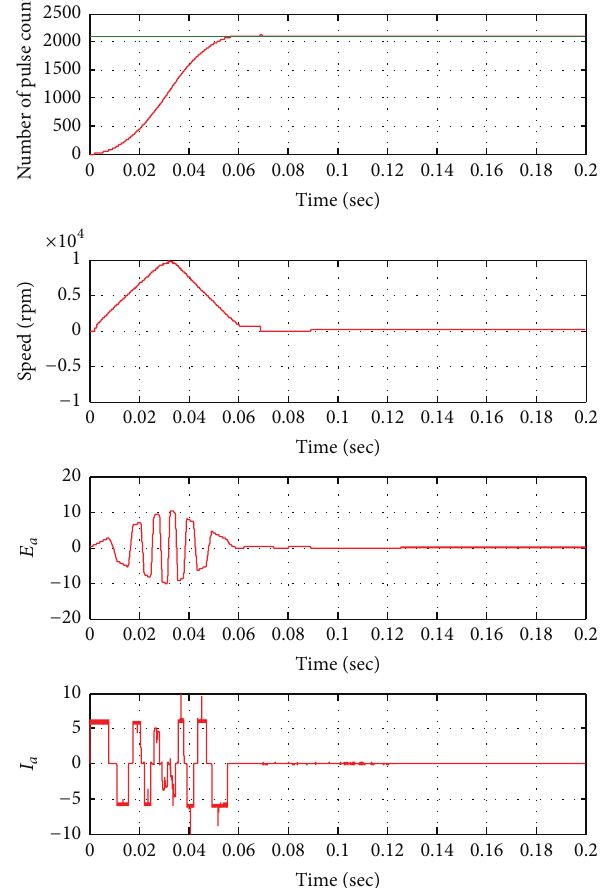
Figure 10: Position response of fuzzy-PID controller based control actuation system for 2100